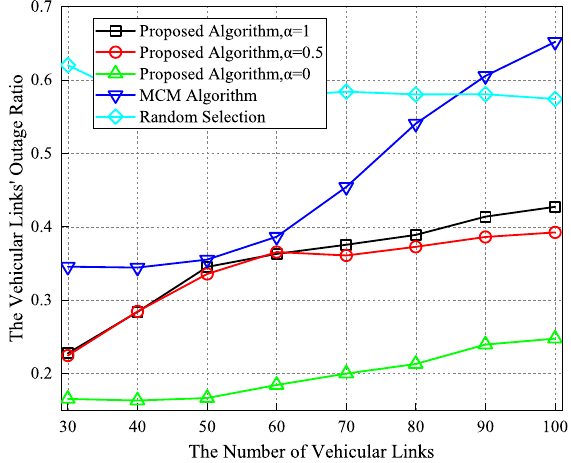
Figure 11. The vehicular link’s outage ratio performance of different schemes with varying V2V